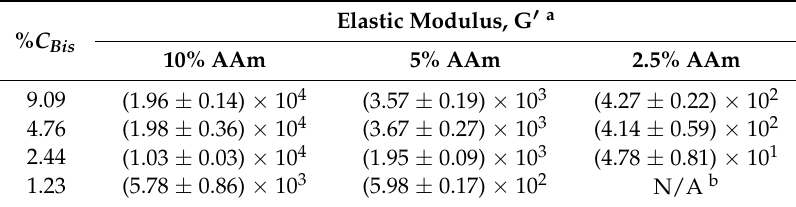
Table 2. Elastic modulus, G ′ , for neat hydrogels for various monomer and relative crosslinker ratios. % C Bis